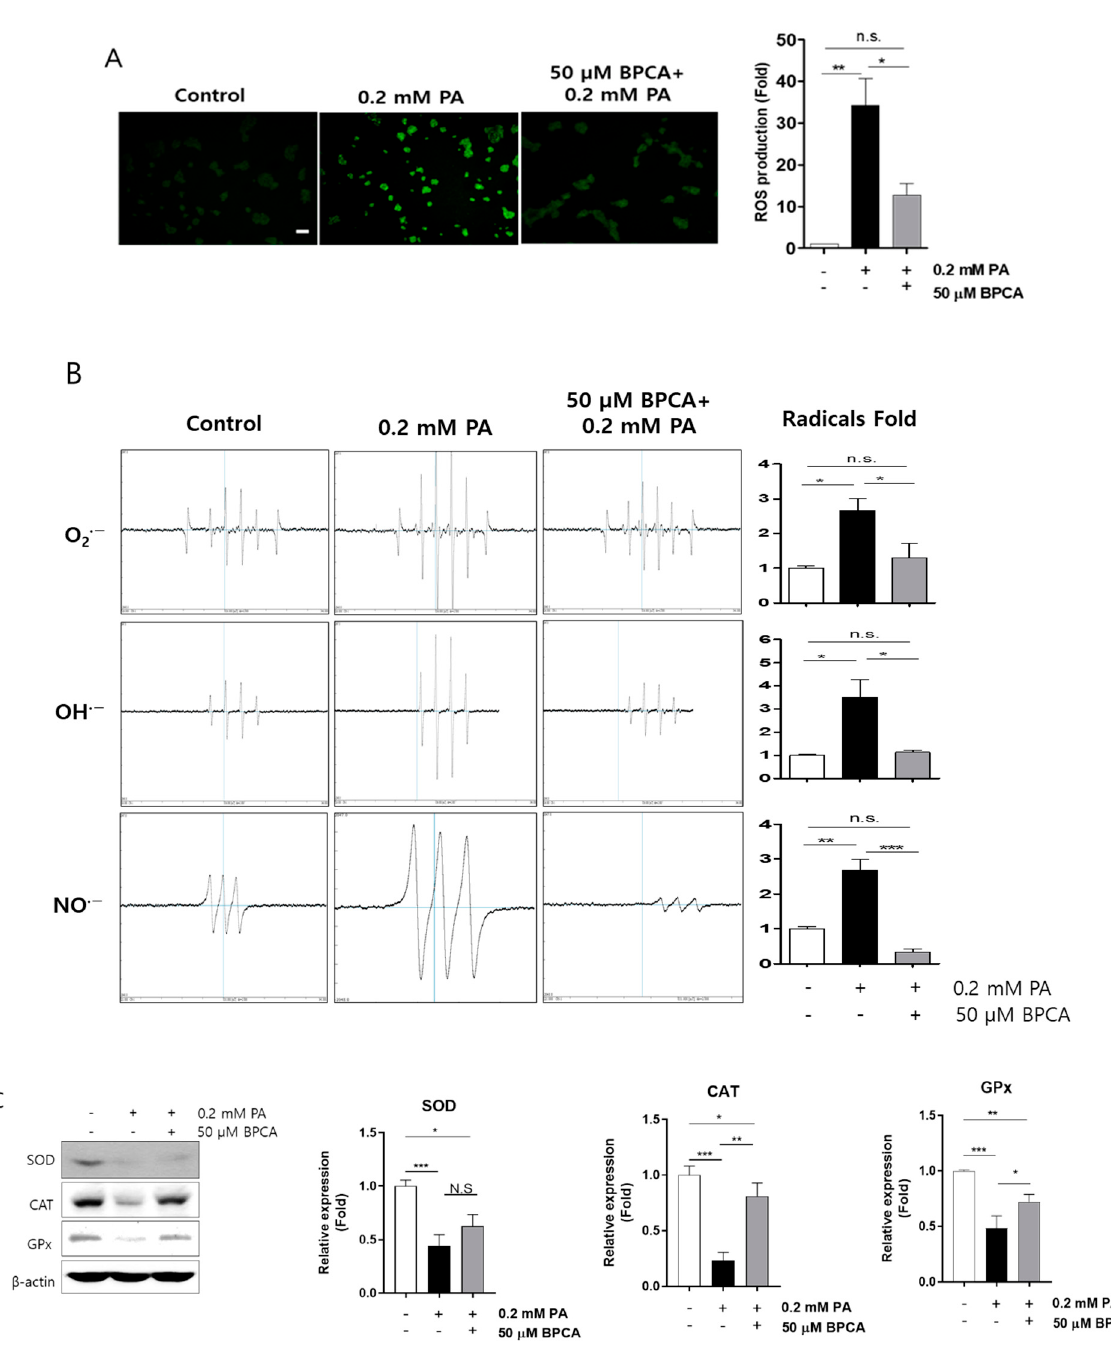
Figure 3. 5-Bromoprotocatechualdehyde (BPCA) isolated from Polysiphonia japonica prevents PA-induced reactive oxygen species (ROS) overproduction by preserving antioxidant enzymes in Ins-1 cells. Ins-1 cells were incubated with 50 μ M BPCA for 1 h, and then further incubated with/without 0.2 mM PA for 12 h. ( A ) Intracellular ROS was subsequently measured using 10 μ M 2,7-dichlorofluorescein diacetate (DCFH-DA). Scale bar: 10 μ m. ( B ) Radical production was subsequently determined using an electron spin resonance (ESR) spectrometer as described in “Materials and Methods”. ( C ) Western blotting was subsequently performed as described in “Materials and Methods”. * p < 0.05, ** p < 0.01, *** p < 0.001, n.s. = no significance.